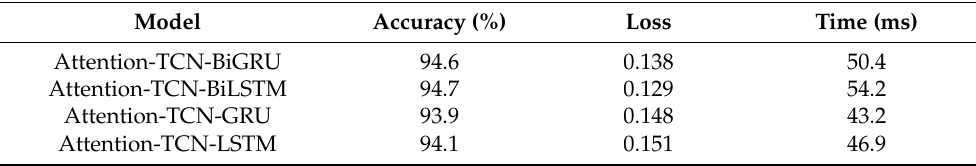
Table 9. Comparison of four